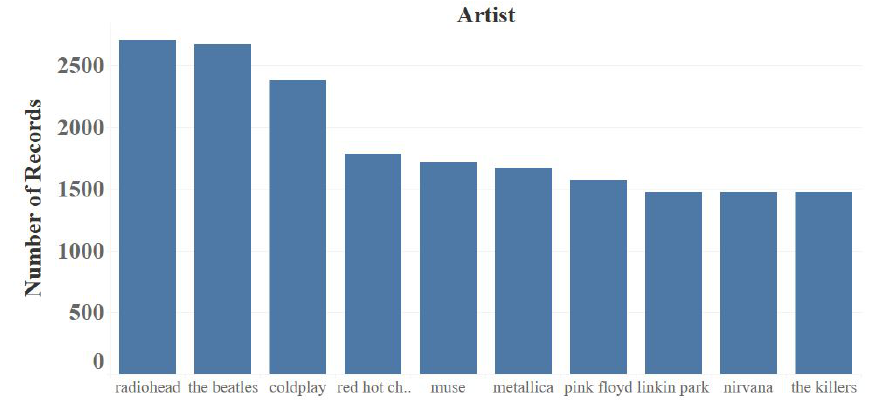
Figure 8. LastFM top ten artists.